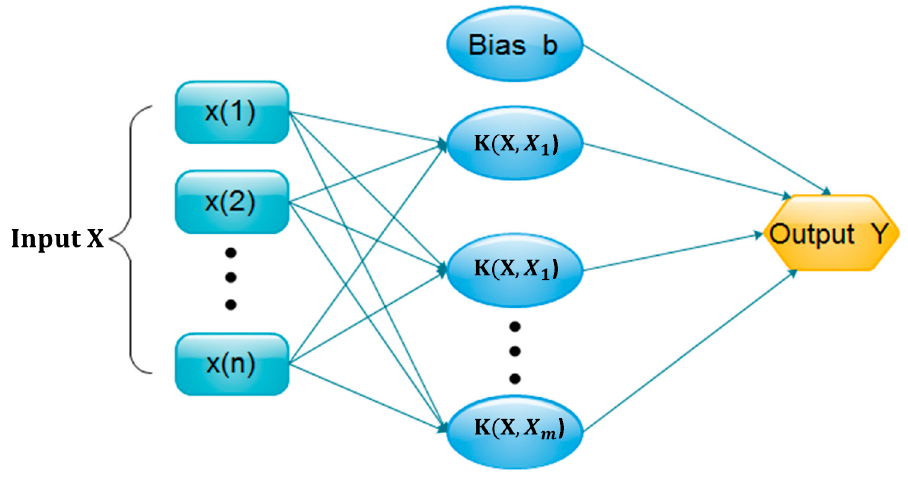
Figure 2. System structure of the Support Vector Machine (SVM ) .